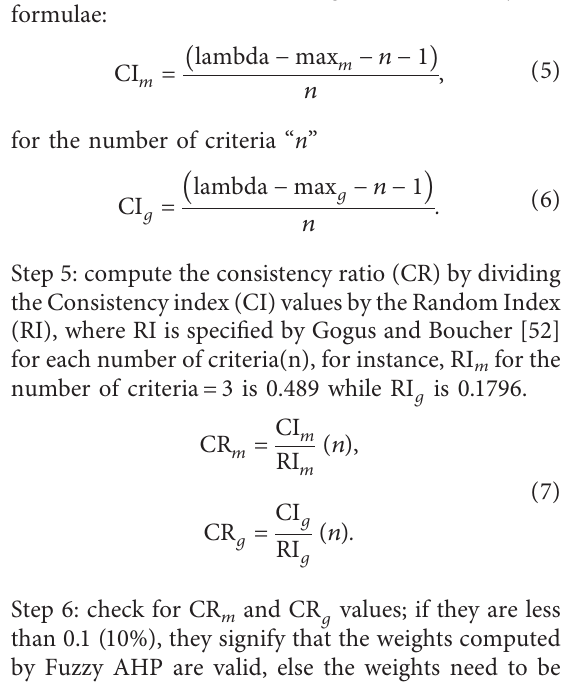
Table 2: Fuzzy linguistic terms with defined triangular scales [50]. Saaty